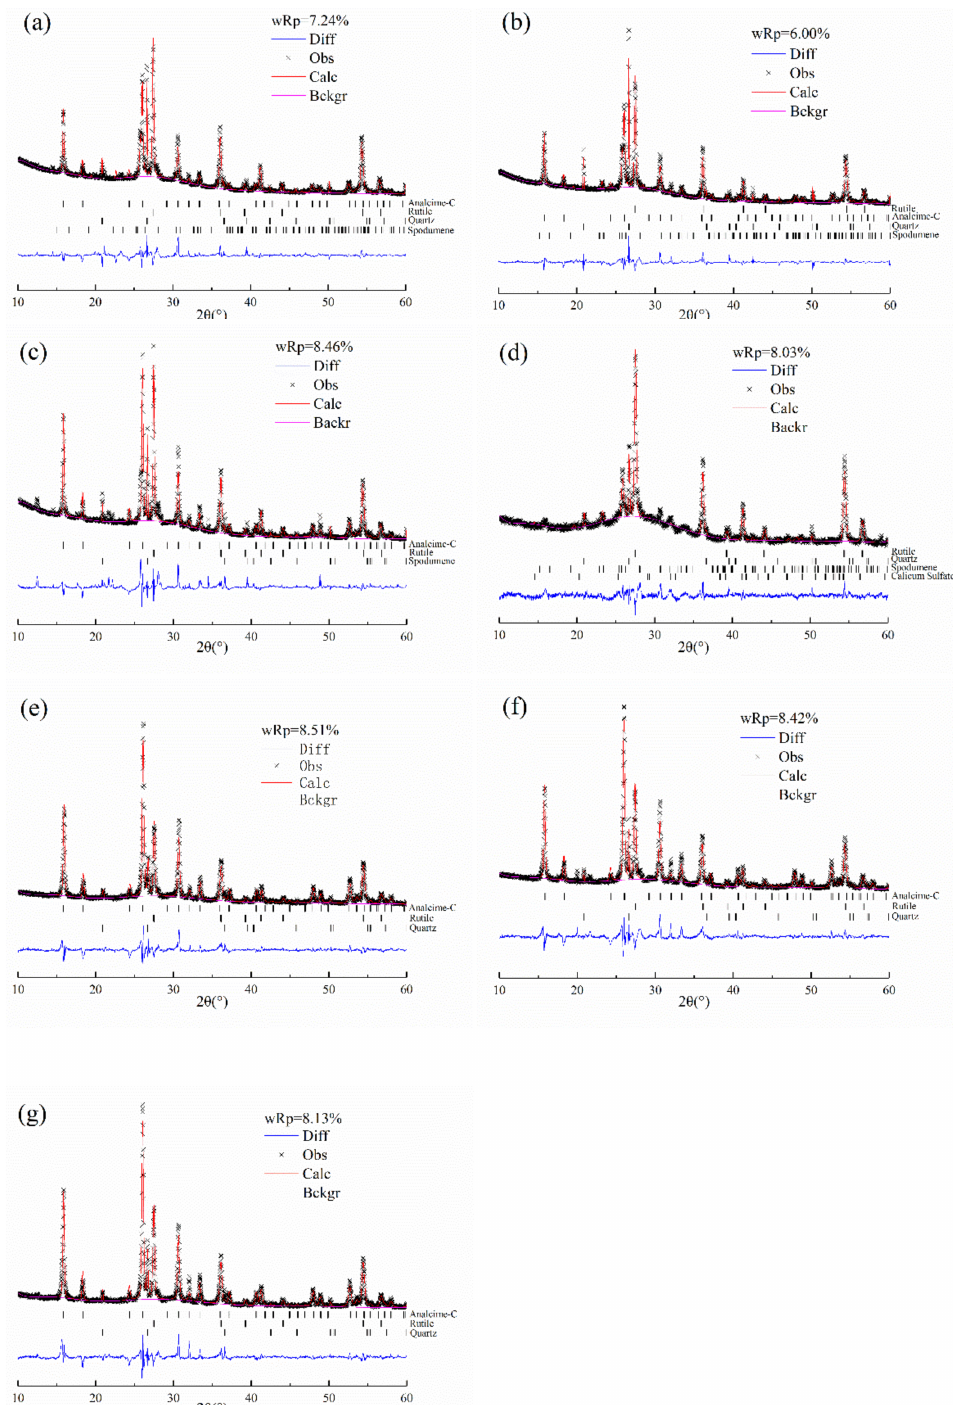
Figure A1. Rietveld quantitative analysis of ( a ) AF1.4, ( b ) AF1.2, ( c ) AF1.0 (AF1-2), ( d ) AF0.5-2, ( e ) AF2-2, ( f ) AF1-1, and ( g )